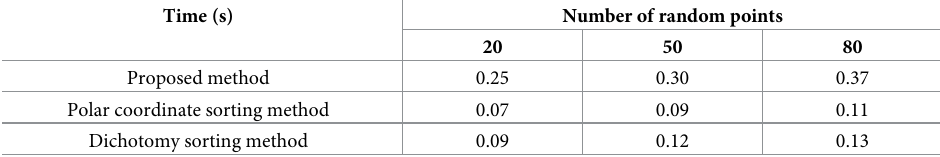
Table 1. Time required to generate a simple polygon.